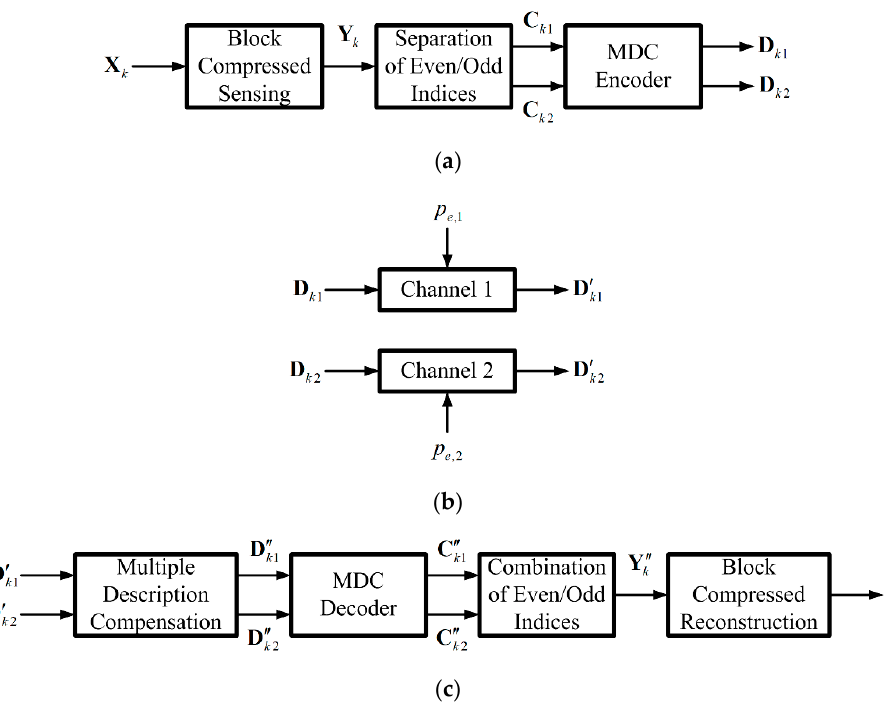
Figure 1. Block diagrams for transmission with block compressed sensing (BCS) and multiple